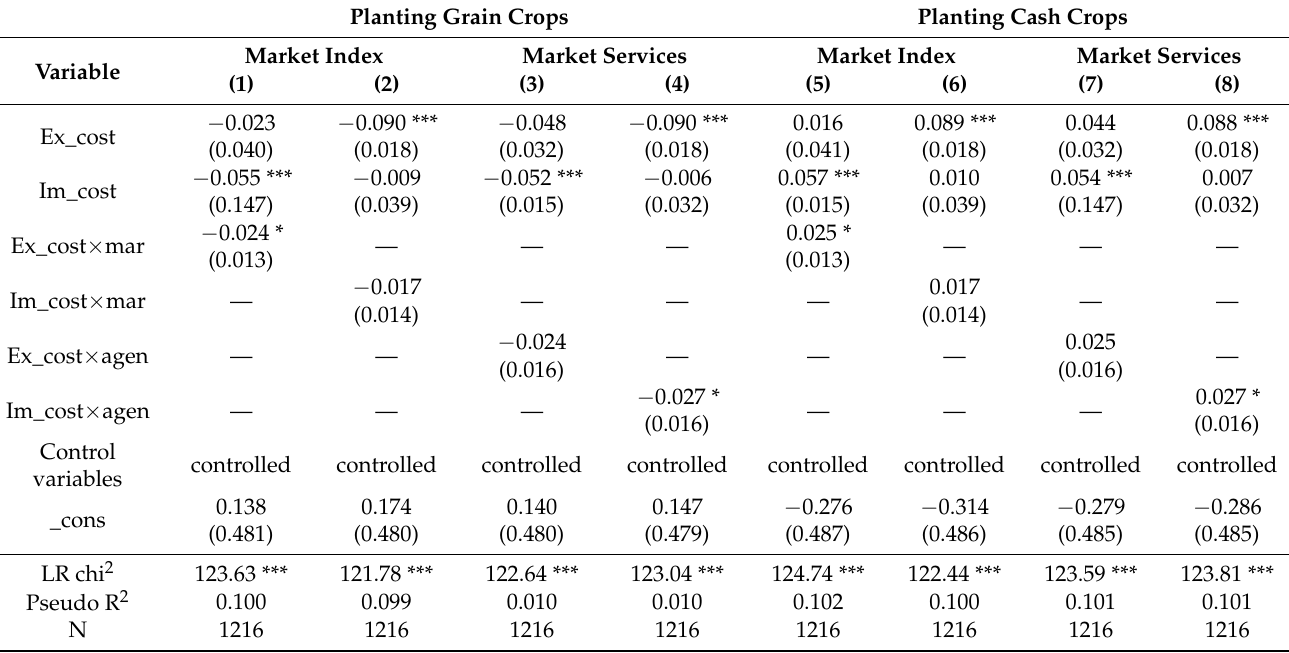
Table 8. Moderating effects of the degree of market